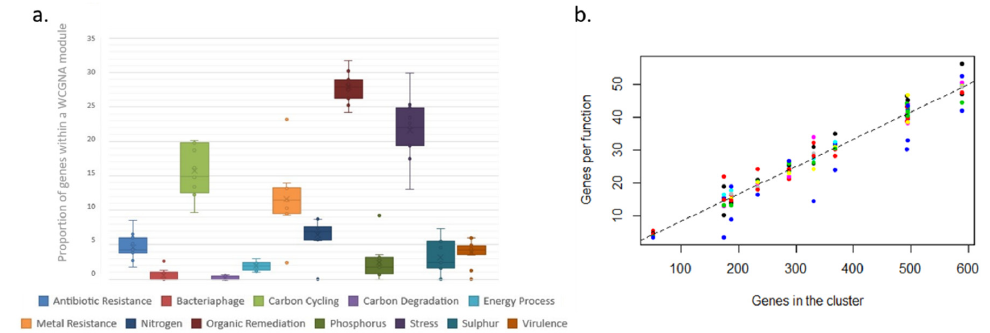
Figure 6. Functional gene distribution within clusters. ( a ) proportion of genes within a WGCNA module. ( b ): linear trend between the number of genes associated to any of the functions and the total number of genes in each KMeans ++ cluster; the individual R 2 values for the linear relations between genes per function and genes in the cluster per cluster vary between 0.71 for virulence genes to 0.99 for stress and carbon cycling genes. The data are presented as standardized for the number of genes per functional type in the